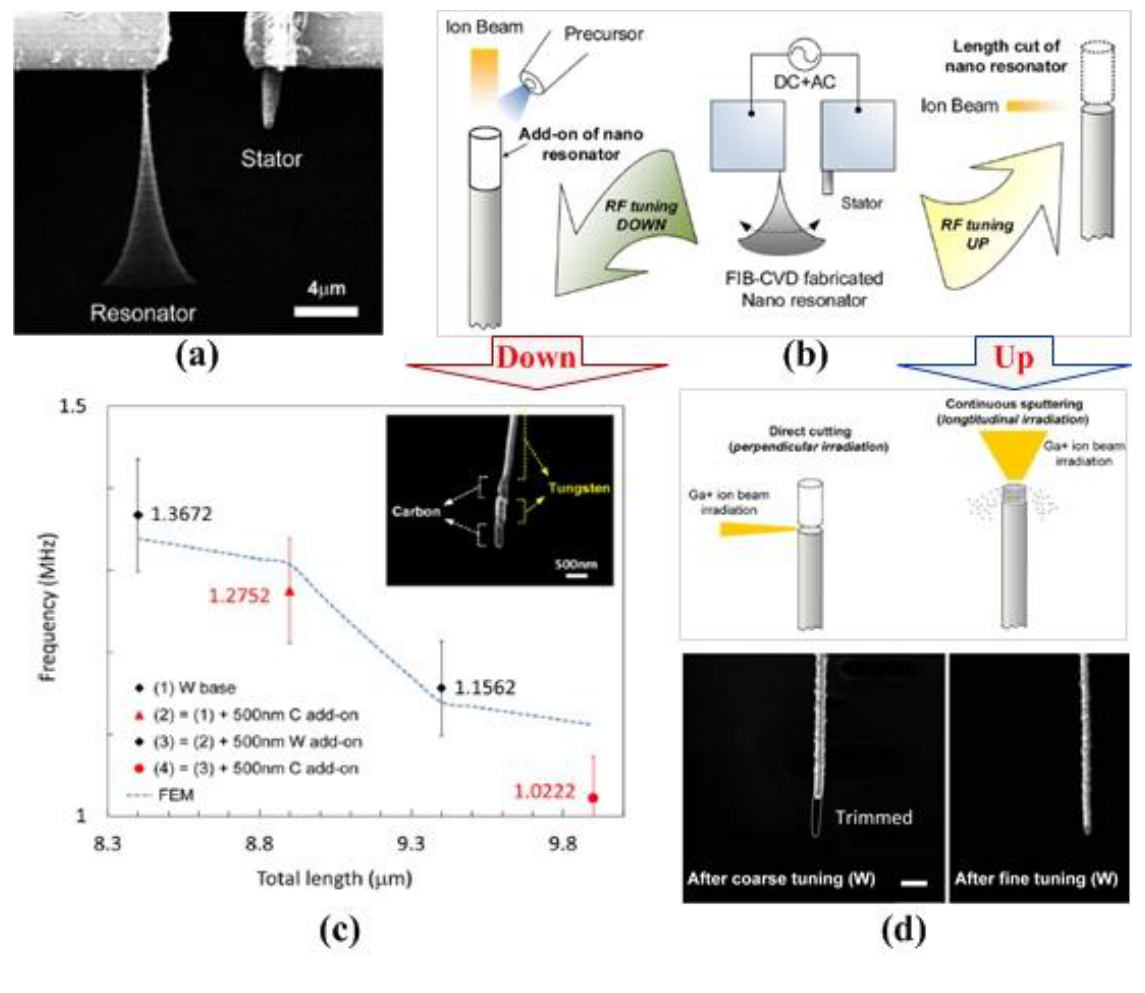
Figure 34. Synthesis and bidirectional frequency tuning of cantilever-shape nanoresonators using FIB-CVD reported by Chang et al . [379]. ( a ) Carbon- and tungsten- based nanoresonators under resonance and a stationary stator; ( b ) Scheme of the synthesis and bidirectional frequency tuning mechanism; ( c ) Resonant frequency adjusted by adding material; ( d ) Resonant frequency adjusted by removing materials. Reused with permission from American Chemical Society, Copyright